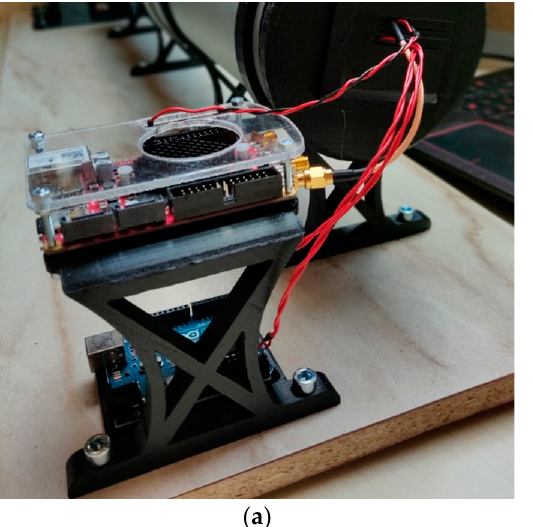
Figure 9. Microcontroller and multifunctional measurement device Red Pitaya holder: ( a ) Multi- functional measurement device Red Pitaya—above; ( b ) Microcontroller Arduino—below. 2.6. Electronic Assembly for Stepper Motor Control To measure the luminous flux of an LED light bulb at various angles, we have to rotate it around its center. This is performed with a stepper motor, which requires an elec- tronic assembly for the controlled and desired rotation of the motor. At the start of the measurements, the sliding table with the light bulb is rotated clockwise to the limit switch.